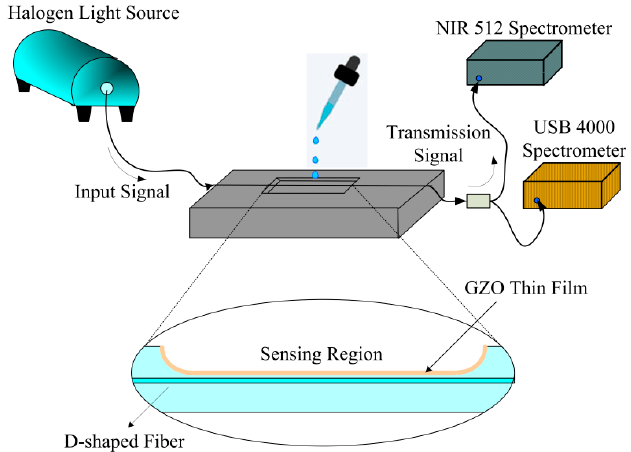
Figure 3. Experimental setup for LMR-based refractive index and salinity sensing.